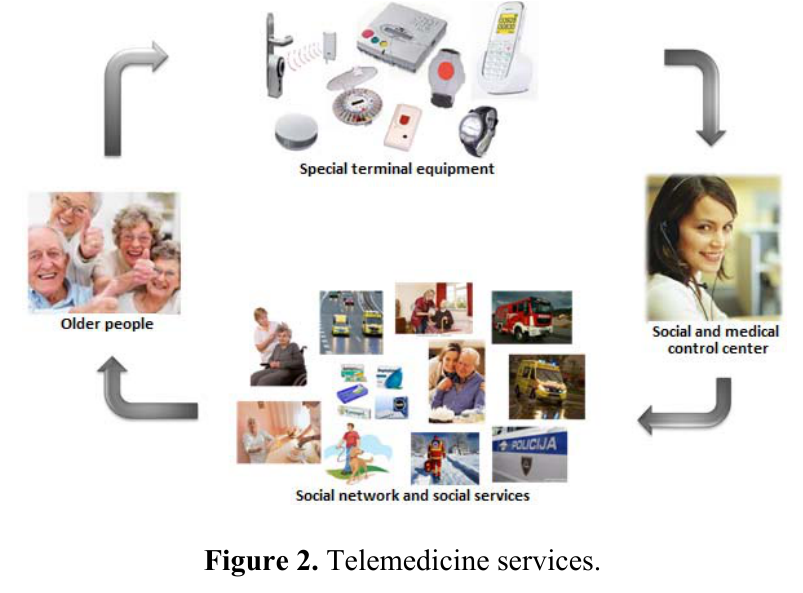
Figure 1. e-Health project: the process of fully integrated health-care delivery.